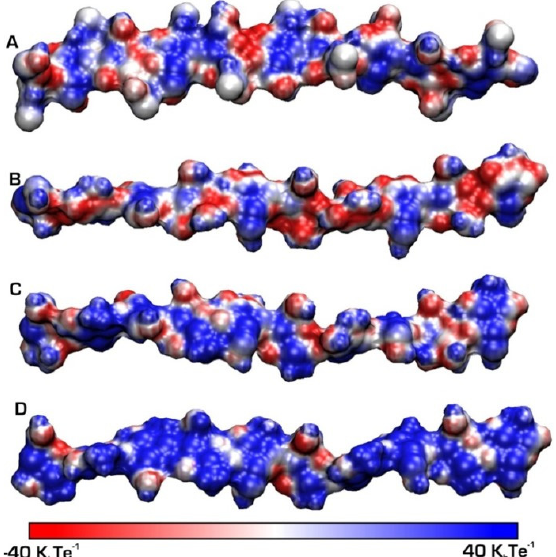
Figure 6. Chitin and chitosan chains simulated at different pH values: ( A ) chitin and ( B ) chitosan at basic (pH = 10), ( C ) chitosan circumneutral (pH = 6.5), ( D ) chitosan acid (pH = 3.5). A positive charge is represented by patches in blue [40] .